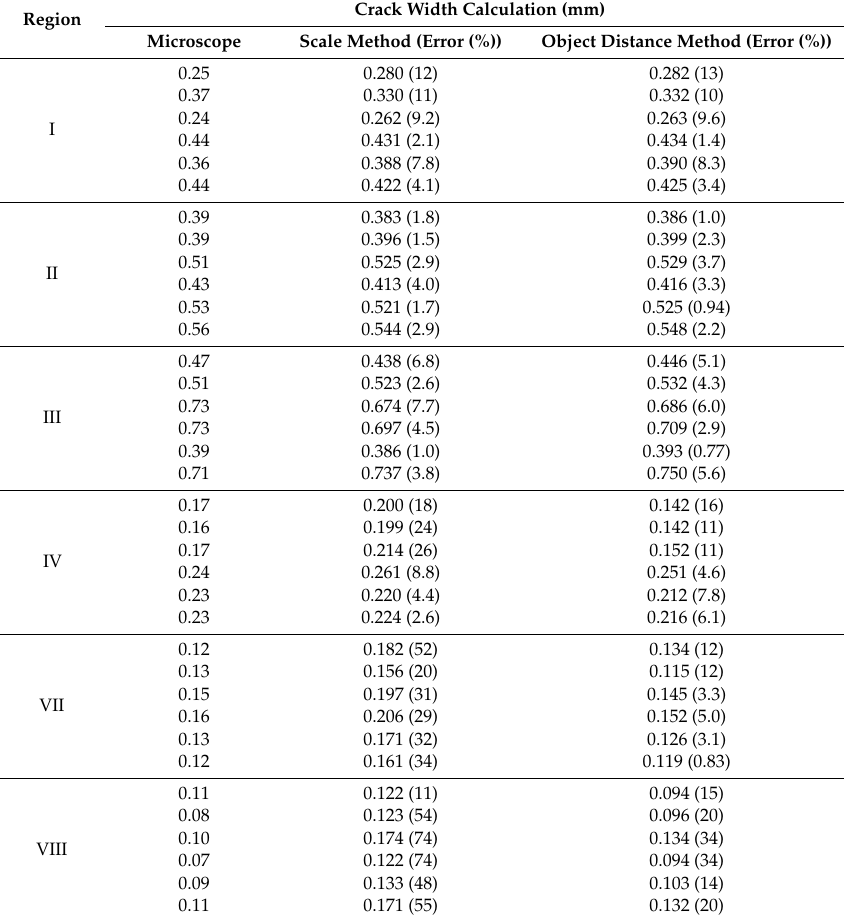
Table 1. Comparison of the obtained crack